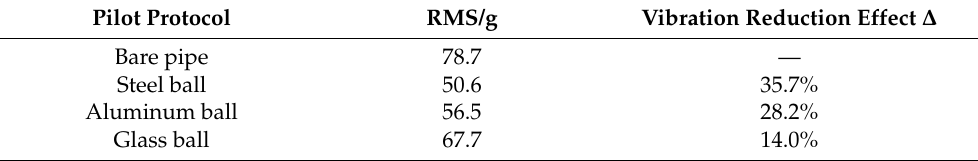
Figure 8. Time responses of damped pipeline with different materials at a 20% filling rate. Table 1. Three materials with 20% filling rate under random